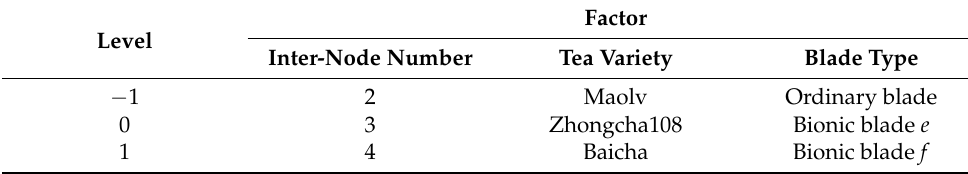
Table 1. Coding of factors.